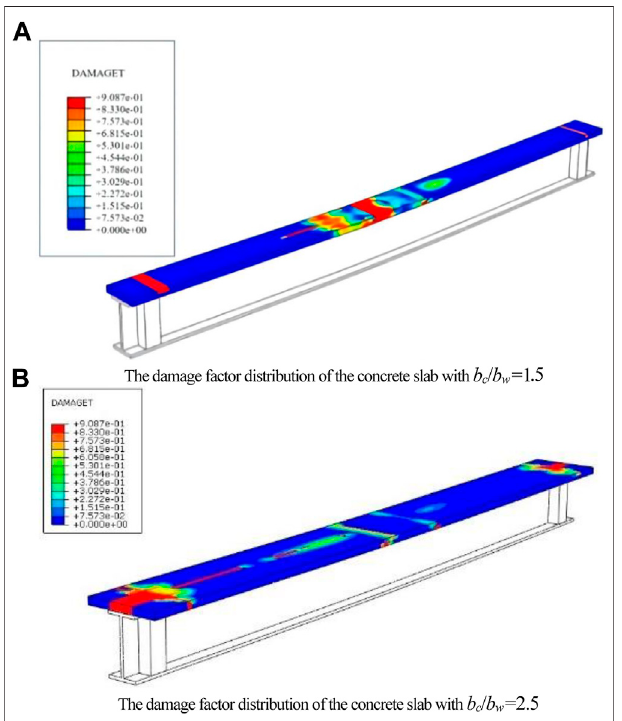
FIGURE 10 | Damage factor distribution of the concrete slab with different width ratios. (A) Damage factor distribution of the concrete slab with b c / b w = 1.5. (B) Damage factor distribution of the concrete slab with b c / b w = 2.5.